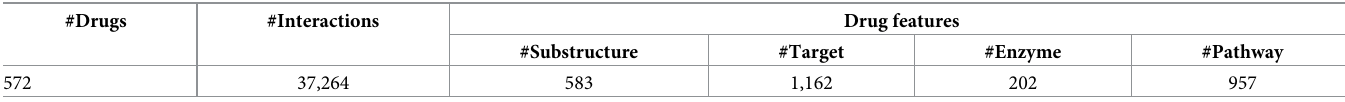
Table 1), so each drug can be represented by a set of 583-bit feature descriptors with the value "1" or "0" indicating the presence or absence of the corresponding substructure. Finally, we can obtain a feature matrix of the chemical structures with the shape of (572, 583), and the same operation is performed on the target and enzyme features. Since the obtained feature matrices have high dimensionality and contain many "0" values, which may degrade the performance of the model, we conduct the Jaccard similarity calculation for each feature matrix to mitigate the impact, as shown in Eq (1).